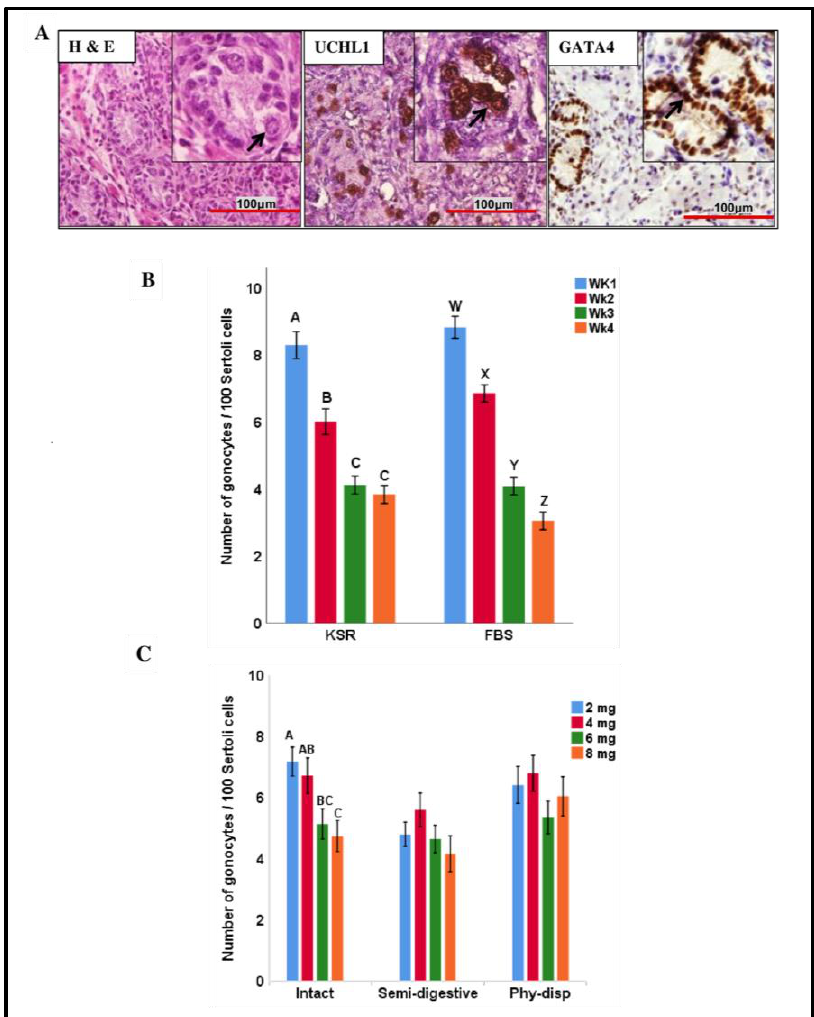
Figure 6. Morphology and relative number of gonocytes in testicular tissue fragments during cul- ture. ( A ) Representative photomicrographs demonstrating the H&E staining and immunostaining of gonocytes (UCHL1) and Sertoli cells (GATA4) after 1 week of culture (arrows). ( B , C ) The relative number of gonocytes (per 100 Sertoli cells) was quantified in samples of tissue fragments. Overall, this ratio decreased over time for tissue fragments in both media supplementation. Among intact fragments, 2 mg tissues had more gonocytes than 6 and 8 mg, while semi-digested or physically dispersed (Phy-disp) fragments of different sizes used did not differ. Data with different letters within each media supplement or preparation method differ significantly ( p < 0.05).